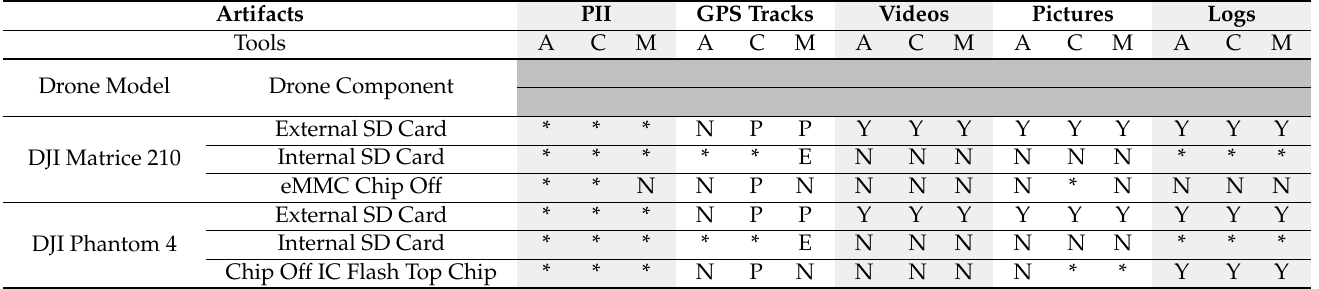
Table 3. Tool evaluation based on DJI Phantom 4 and DJI Matrice 210 UAVs.